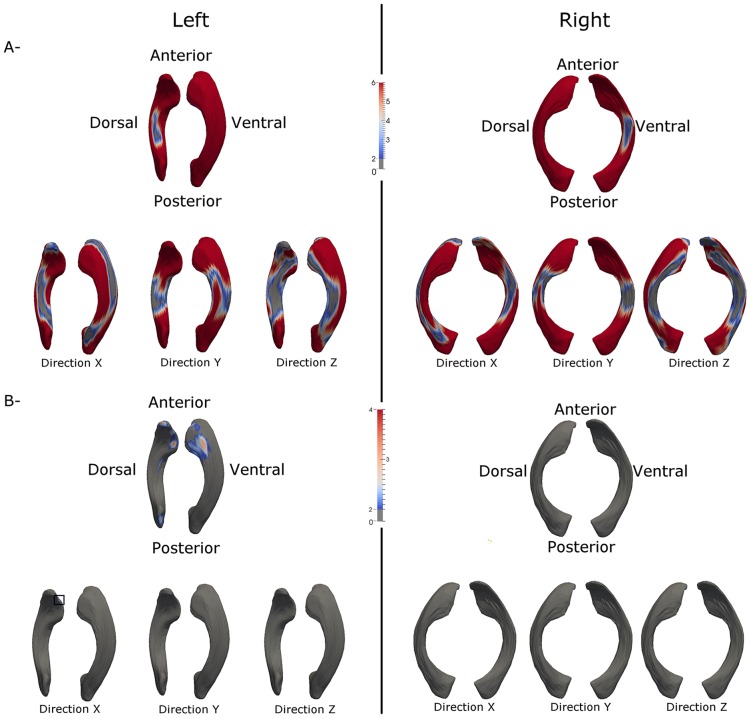
The effects of age and gender on shape growth of the ventricles.(A) The effects of age on the shape growth of the left and right ventricles are shown, respectively. The upper row shows the effects without considering the direction of growth while the age effects on the growth of ventricle along the left-right (X), anterior-posterior (Y), and superior-inferior (Z) directions are shown in the bottom row, respectively. The (–log10(p-value)) corrected for multiple comparison using FDR is overlaid on the ventricles and the color bar represents the –log10(p-value). (B) The effects of gender on the shape growth of the left and right ventricles are shown, respectively. The organization of Fig. 8B is identical to that shown in A.